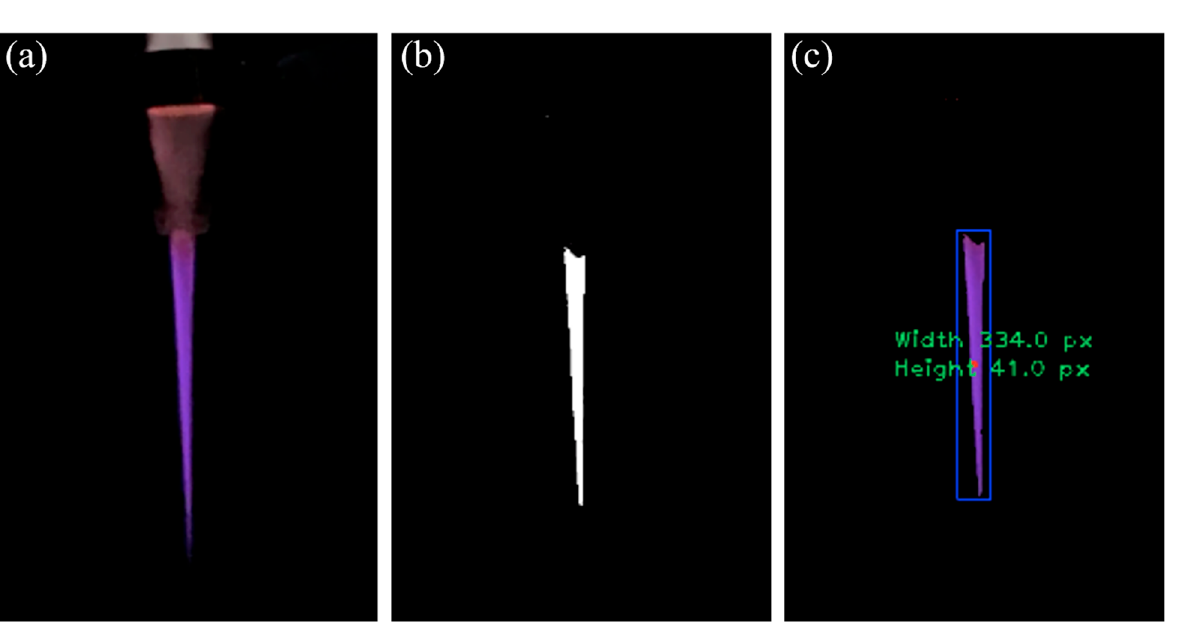
Figure 4. The main GUI windows of the program. ( a ) The frame window was inputted; ( b ) a mask was created to identify purple; ( c ) and a bounding box was drawn to surround the plasma plume region. Box dimensions on the screen were displayed in pixels so the program could start without relying on camera calibration. Only if data were collected was calibration required. In this case, pixel values were converted to centimeters and saved if the camera position was calibrated using an ArUco marker.